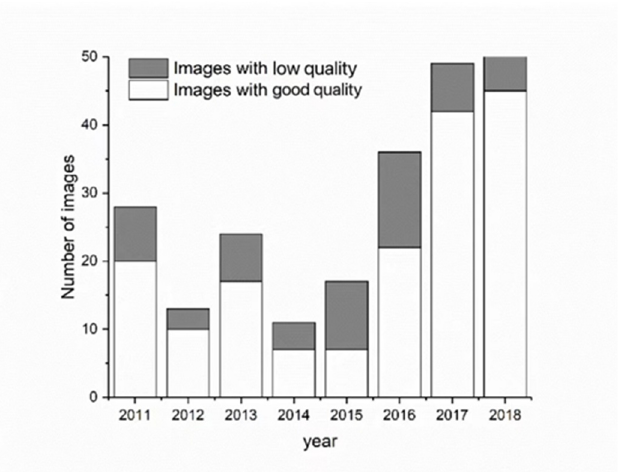
Figure 2. The diurnal temperature range (DTR) data (MOD11A1) during spring irrigation from 2011 to 2018 (16 January–5 May).